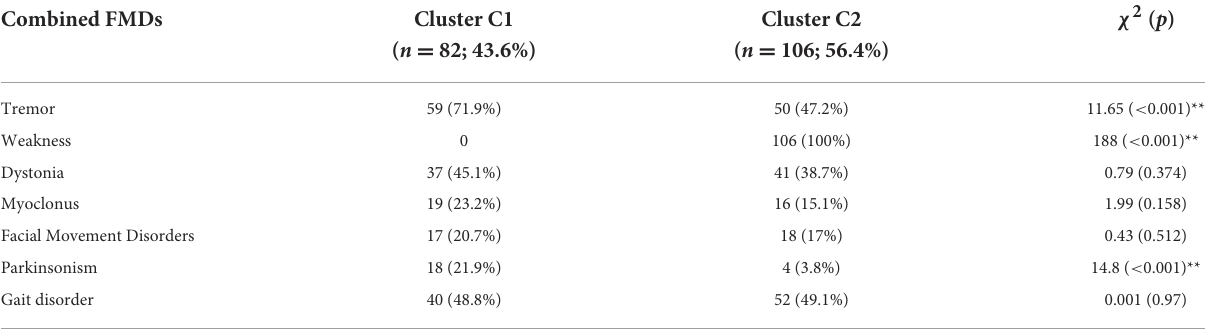
TABLE 1 Distribution of FMDs among identified clusters.